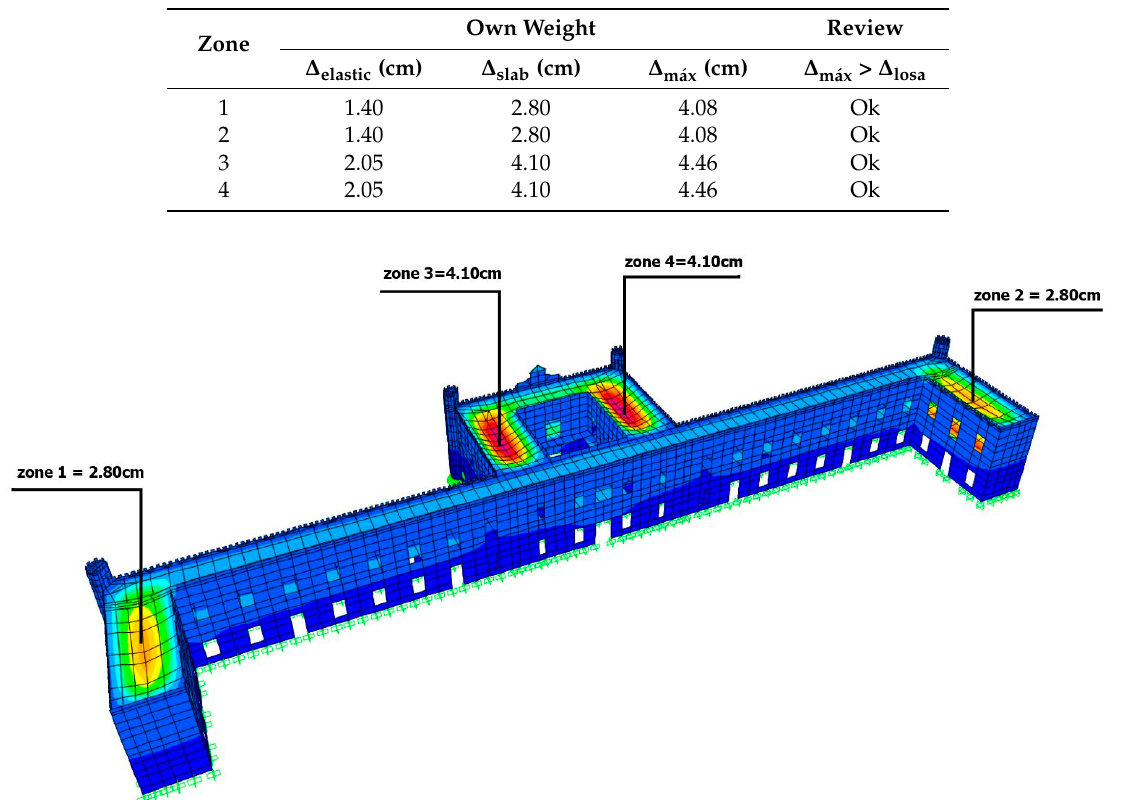
Figure 9. Displacements by own weight and maximum live load in vertical direction (cm) [12].